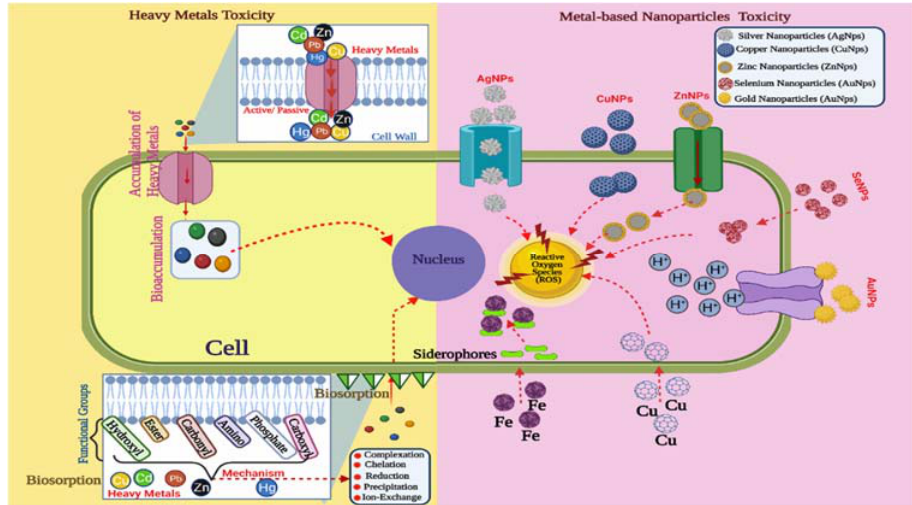
Figure 5. The adsorption and absorption mechanisms in the cell walls caused by the presence of functional groups, proteins, or compounds that serve as chelating agents, as well as the accumulation of these in the vacuoles, are illustrated schematically in the Trichoderma tolerance mechanisms to micro- and nano-metals. Mechanisms involving antioxidant enzyme activity that reduces the damage produced by reactive oxygen species may also be present. The arrows indicate movement of the metal ions or nanoparticles affecting specific organelle in the cell. The present figure was created by BioRender.com.